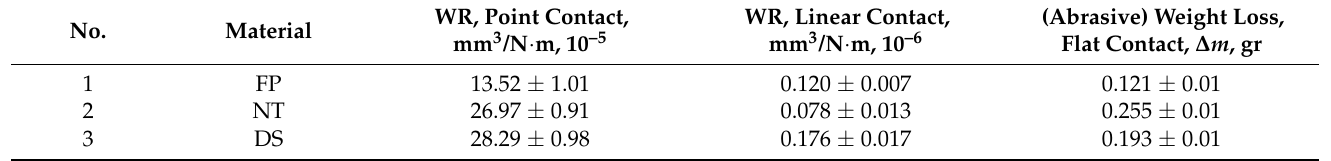
Table 6. The summarized data on the WR values in the point, linear, and flat tribological contacts.